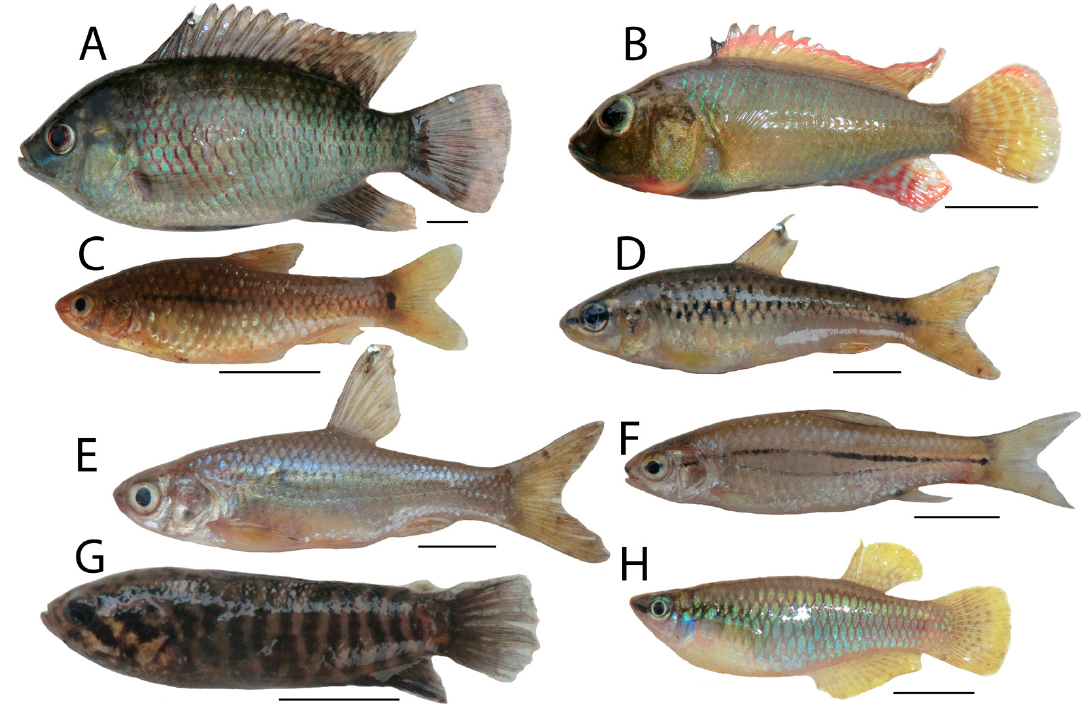
Figure A5. Selected species shared with the Zambezi headwaters: ( A ) Coptodon rendalli ( B ) Pseudocrenilabus philander ( C ) Enteromius brevidorsalis ( D ) Enteromius chiumbeensis ( E ) Enteromius paludinosus ( F ) Enteromius bifrenatus ( G ) Microctenopoma nigricans ( H ) Hypsopanchax jubbi. Photographed immediately postmortem, scale = 1 cm.